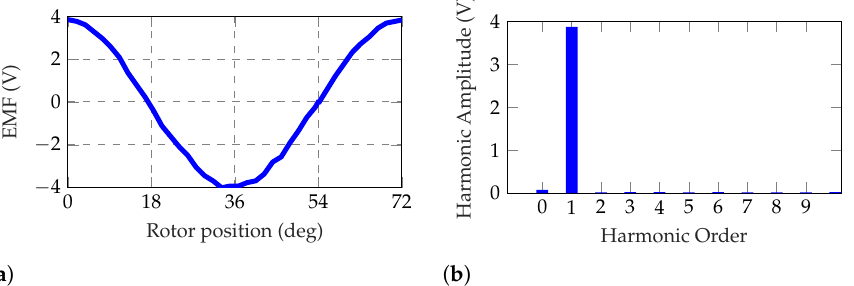
Figure 23. No-load EMF waveform and harmonic content of the 12/10 spoke-type PM motor, experimental results. ( a ) Flux-linkage waveform. ( b ) Harmonic content.